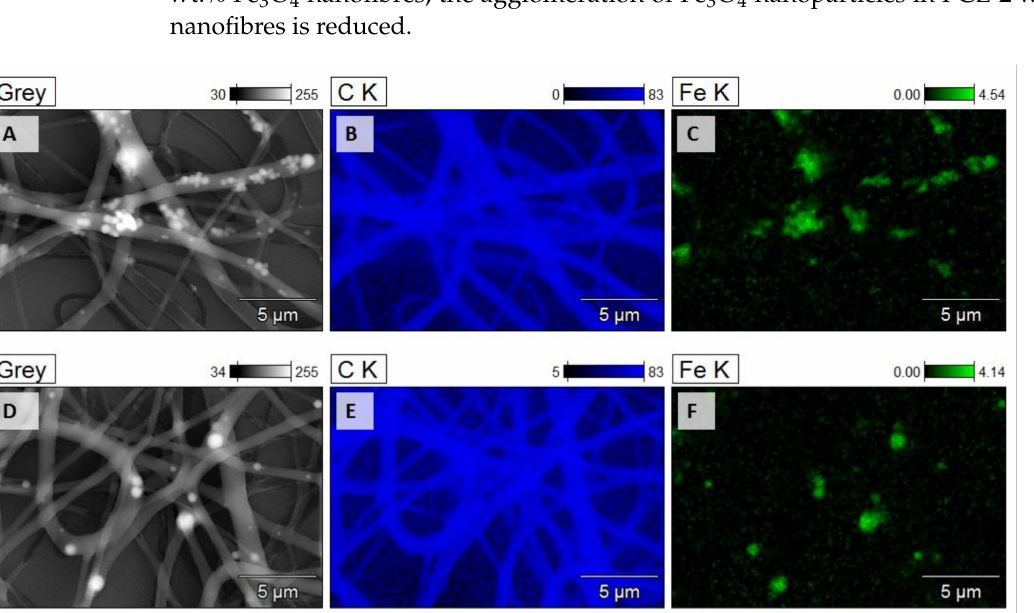
Figure 4. Elemental mapping of PCL nanofibres loaded with 6 wt.% ( A – C ) and 2 wt.% ( D – F ) magnetite nanoparticles respectively by